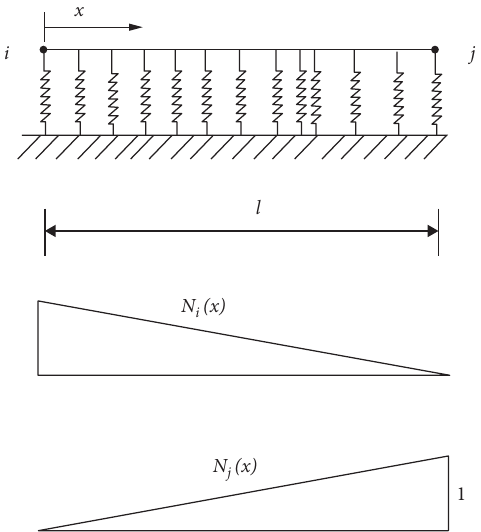
Figure 4: Normal displacement shape